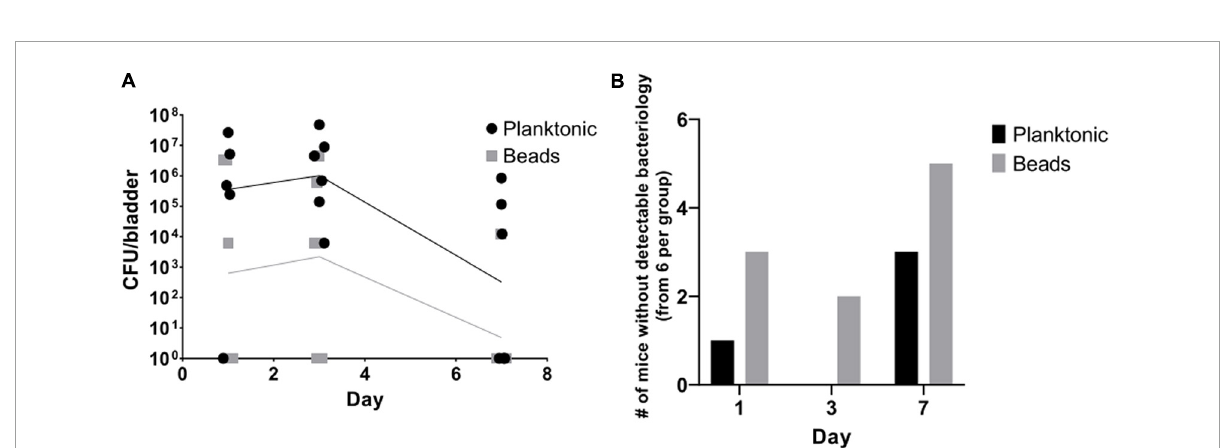
FIGURE2 Planktonic bacteria achieve more stable infections than alginate-embedded (beads) bacteria in vivo . Alginate embedded bacteria were produced prior to the procedure as described in the methods. Planktonic and embedded bacteria were adjusted to 1 × 10 8 CFU/mL on the day of experiment start. Thirty-six 10-week old female Balb/c mice were anesthetized and randomized in equal groups receiving 50 µ L of either planktonic or alginate embedded bacteria. On days one, three and seven, six mice from each group were euthanized. Blood, kidneys, and bladders were harvested. The organs were homogenized and quantitative bacteriology was evaluated the next day. Displayed are the CFU (lines connect geometric means) detected in the bladders of the mice (A) and the amount of mice without any detectable bacteria in the bladder (B)